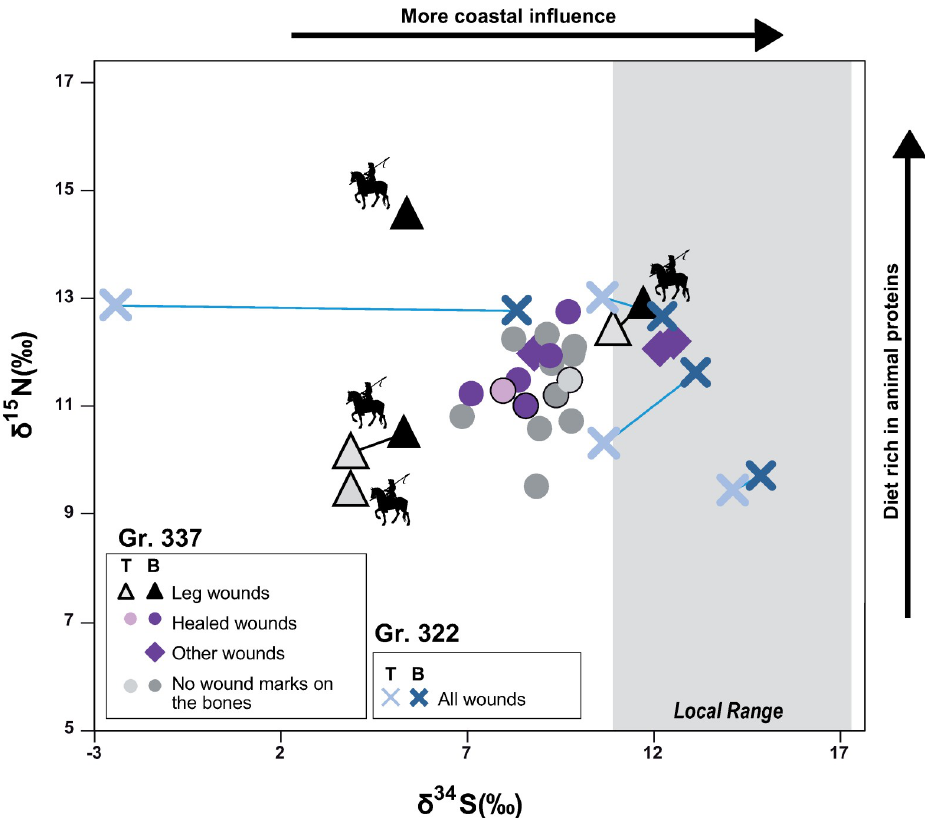
Fig 5. Nitrogen and sulfur isotope data of the soldiers in the graves 337 and 322 in relation to their wound marks on bones. T stands for teeth values and B for bones.